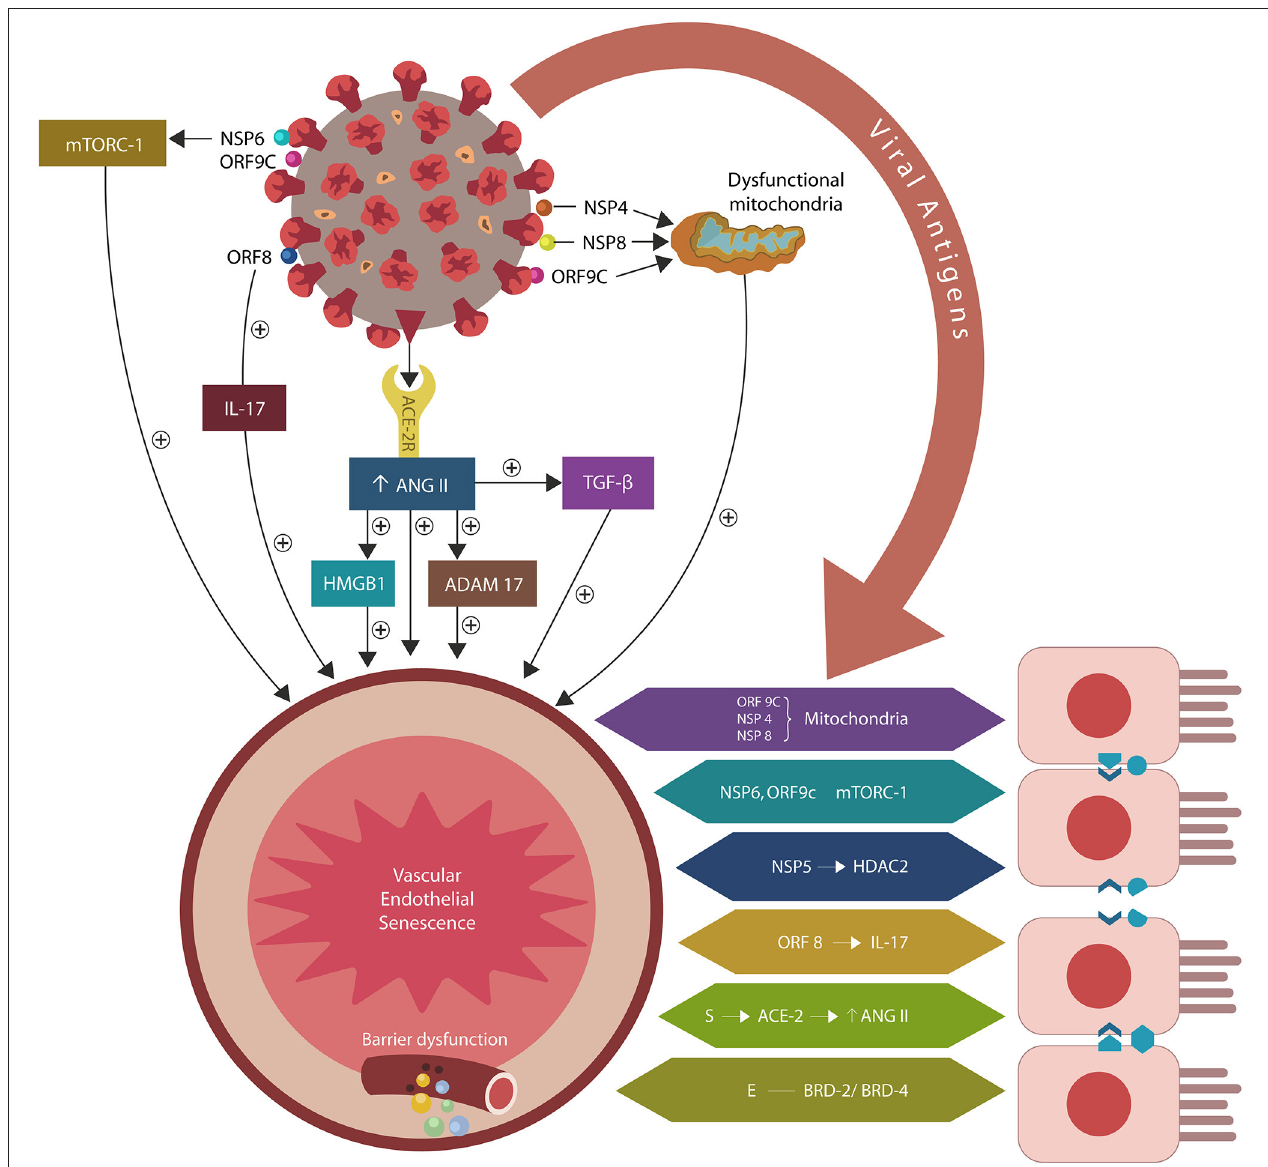
FIGURE 1 | SARS-CoV-2/host protein-protein interactions. Viral crosstalk with several host proteins disrupts both endothelial cells (ECs) and intestinal epithelial cells (IECs), damaging the gut barrier and facilitating microbial and/or lipopolysaccharide (LPS) translocation into host tissues, including the skeletal muscle and the brain. Endothelial senescence also contributes to the disruption of blood-brain barrier (BBB), allowing microbial and/LPS access into the CNS. It is noteworthy that the cross talk between viral E antigen and host bromodomains (BRDs) 2 and 4 triggers macrophage senescence, impairing the elimination (efferocytosis) of aging cells. Viral S antigen attachment to ACE-2 receptor (ACE-2R) is followed by ANG II upregulation. This augments TGF- β , HMGB1, ADAM17, and ICAM-1 (not shown), inflicting endothelial and intestinal cells dysfunction with barrier